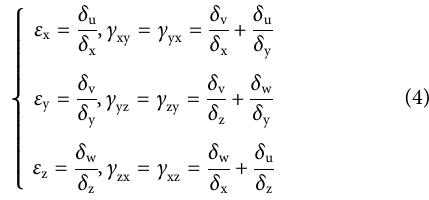
FIGURE 2 Stratigraphic systems and tectonic activities in the study